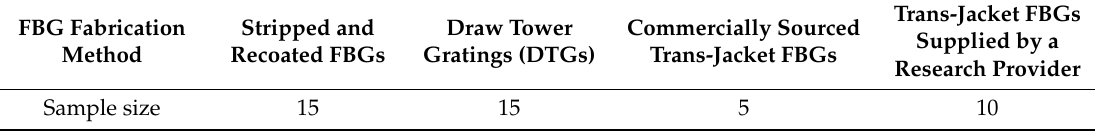
Table 2. FBGs sensor test matrix.